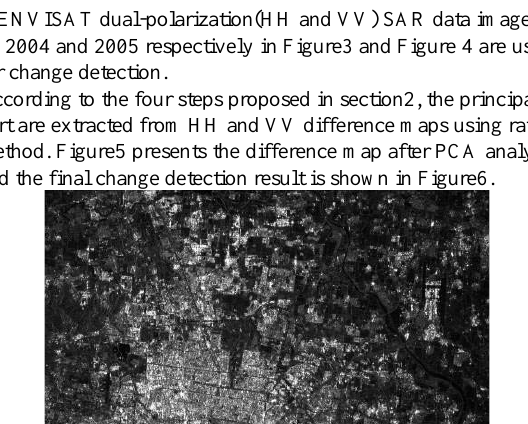
Figure 3. ENVISAT SAR data(HH, 2004)